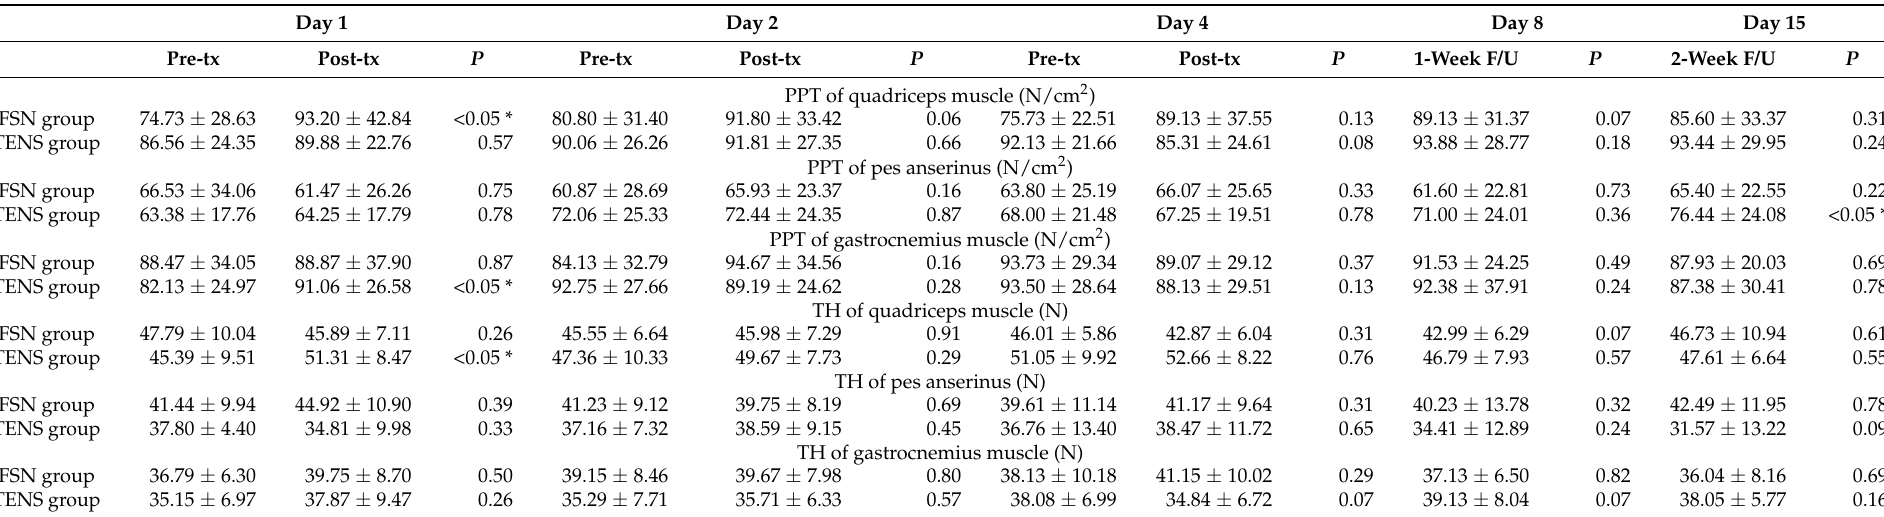
Table 3. Muscle and tendon qualities (including PPT and TH) compared between the FSN and TENS